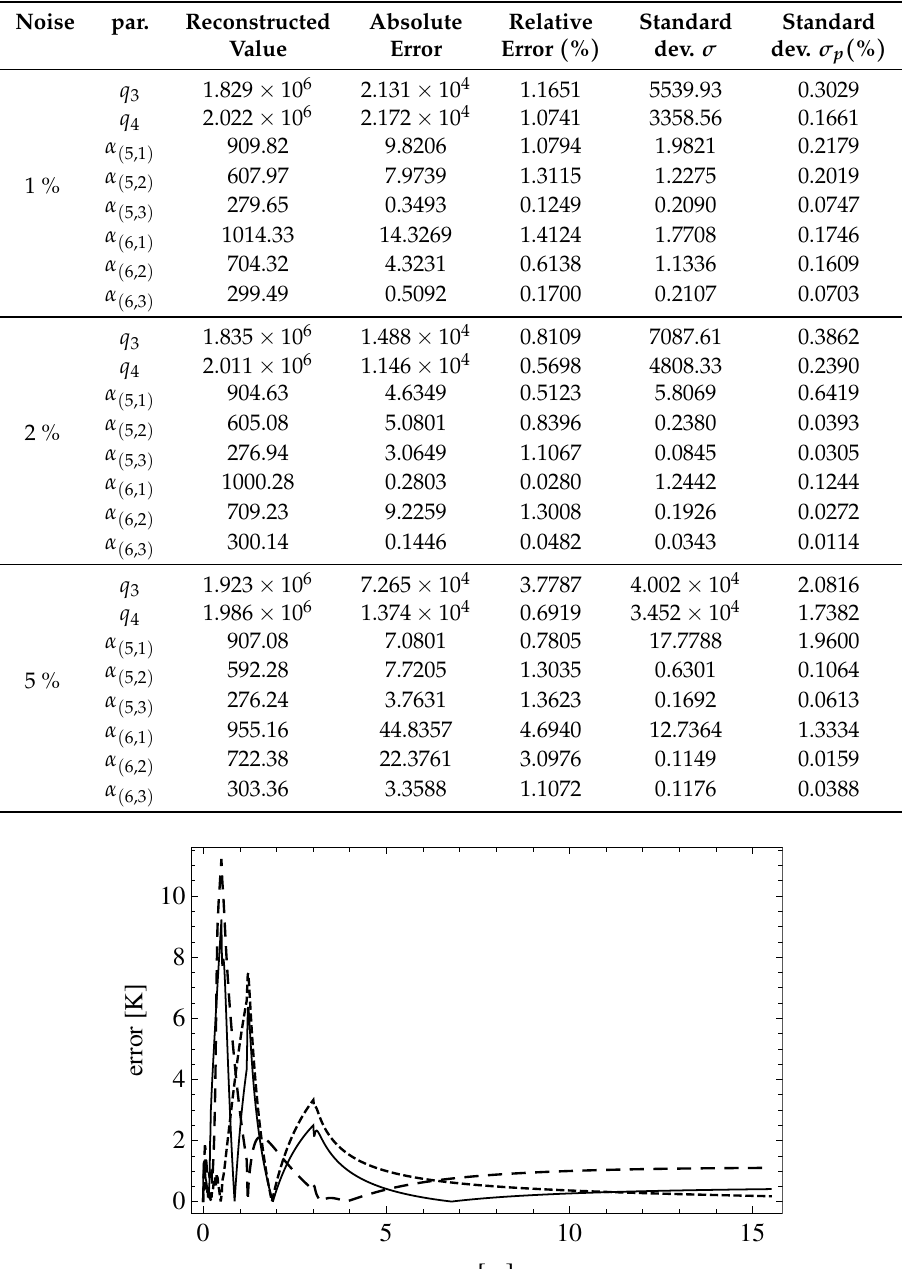
Table 7. Reconstructed values of the unknown coefficients together with the absolute and relative errors of these reconstructions, the standard deviation σ and the standard deviation σ p taken as the percentage of the best reconstructed value, obtained for the measurements read at every 0.01m (four steps optimization).